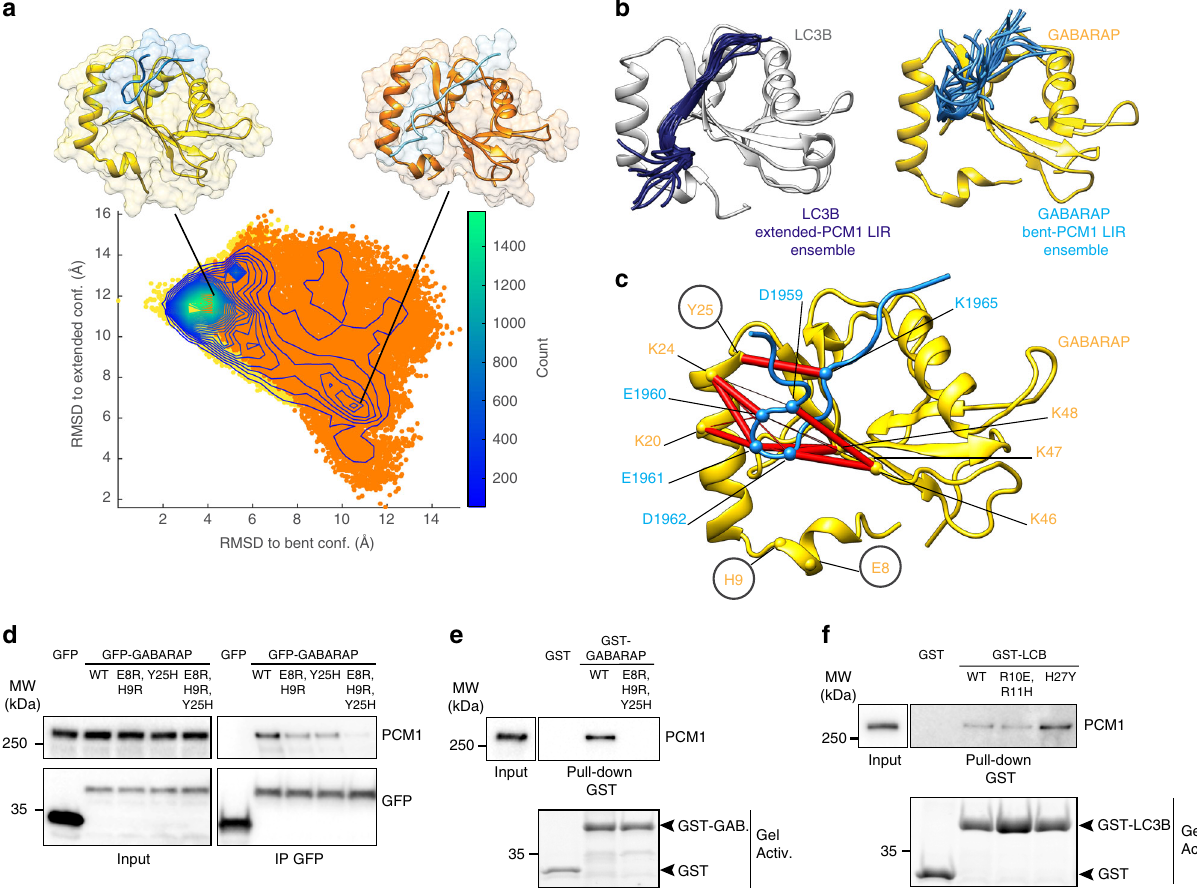
Fig. 5 Structural analysis of GABARAP-PCM1 peptide complex. a Density plot for the conformations of PCM1 LIR in the GABARAP binding pocket, sampled during simulations starting from the bent (in yellow) and extended (in orange) conformations. The plot illustrates the similarity of the PCM1 LIR (light blue cartoon) conformations (measured as all-atom RMSD) with respect to each of the two initial structures for the simulations in complex with GABARAP (i.e., the bent and the extended conformation in yellow and orange cartoons, respectively). Starting from different conformations, the simulations of the PCM1 LIR into the GABARAP pocket converge on a similar ensemble of bent structures. b The common ensemble of bent structures of the PCM1 LIR peptide and ten representative conformations were isolated and are shown as a light blue cartoon. As a comparison, ten structures of the PCM1 LIR peptide from the simulations in complex with LC3B were reported and are indicated as dark blue cartoon. c Pairwise intermolecular contacts between residues of GABARAP and PCM1 LIR peptide were estimated in the selected ensemble. Contacts are represented as red cylinders connecting the C α atoms of the pair of residues involved in the interaction. The radius of each cylinder is proportional to the occurrence of the contact, e.g. a contact presents in all structures of the selected ensemble has a radius of 0.5 Å. We here report the most important residues of GABARAP (yellow cartoon, E8, H9, K20, K46, K47, K48, and Y25) for the interaction between the 1959-DEED-1962 and K1965 of PCM1-LIR (light blue cartoon). The residues selected for experimental mutagenesis are circled and their C α atoms are shown as spheres. d GFP-precipitation of GFP-3xFLAG or GFP-tagged GABARAP-wt or the indicated mutants in HEK293 cells analyzed for co-precipitation of endogenous PCM1, n = 2. e GST pull-down of GST, GST-GABARAP-wt or the indicated mutant analyzed for co- precipitation of endogenous PCM1, in HEK293 cells, n = 2. f GST pull-down of GST, GST-LC3B-wt or the indicated mutants analyzed for co-precipitation of endogenous PCM1, in HEK293 cells, n =